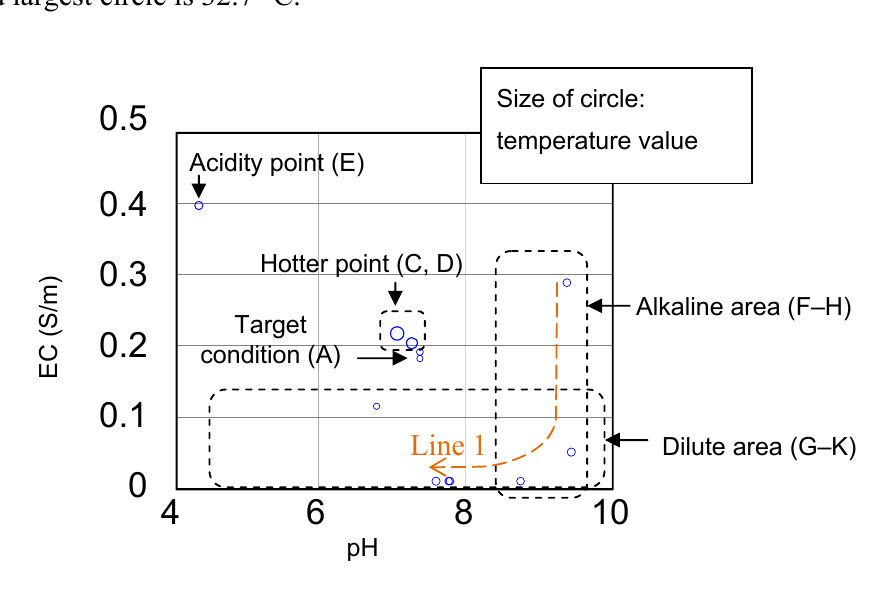
Figure 13. Comparing results of pH, EC and temperature in sensor outputs of Table 2 is shown. The size of circle was varied by temperature value, for example, smallest circle is 26.0 °C, and largest circle is 32.7